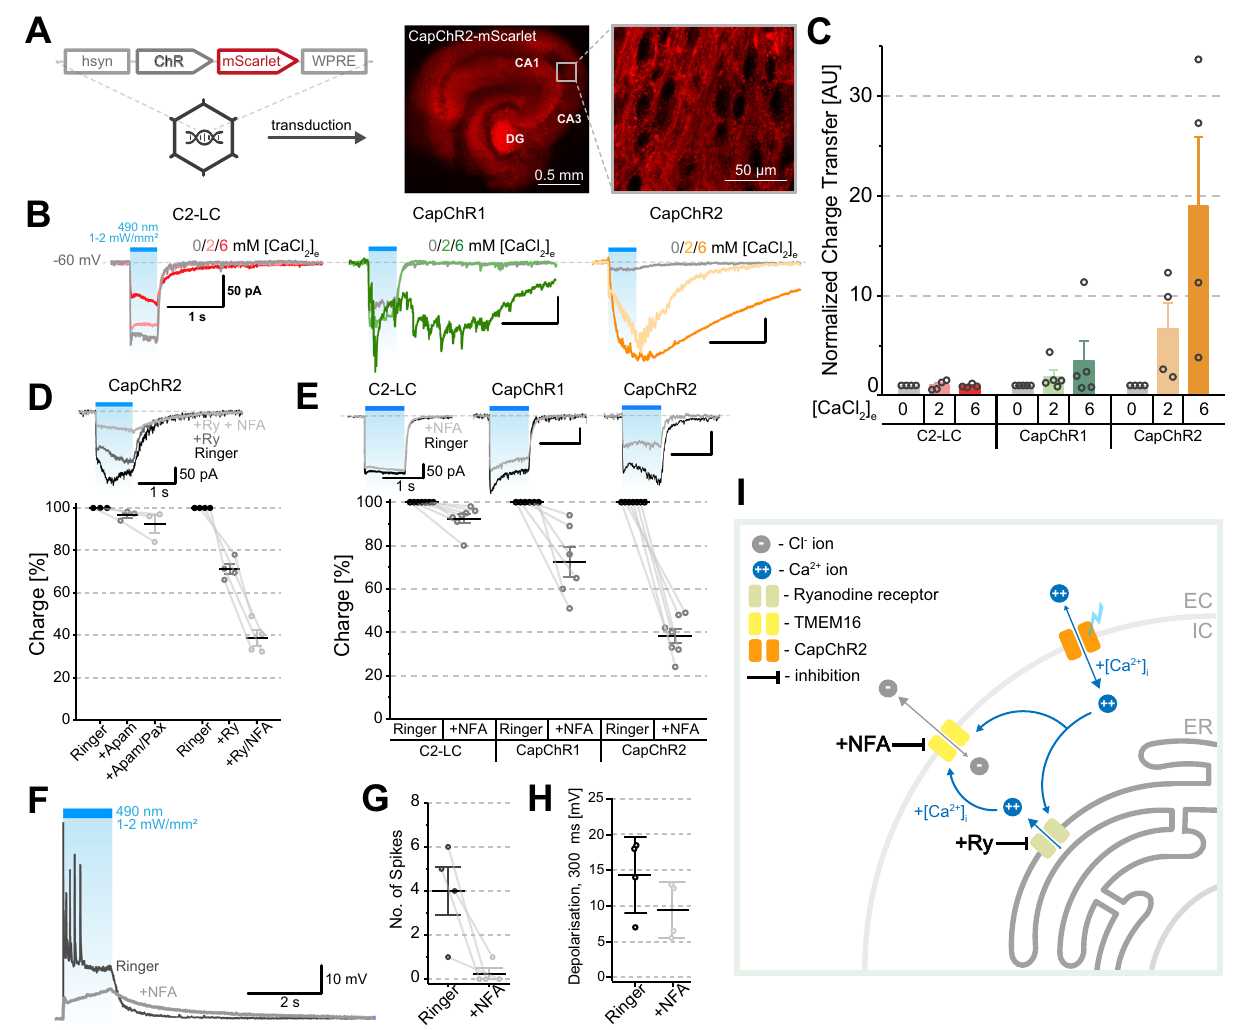
Fig. 6 | Electrophysiological characterization of CapChRs in organotypic hip- pocampalsliceculture.A Constructdesignand fl uorescentconfocalmicrographs showing organotypic hippocampal cultures (DIV 20) transduced with AAVs- expressing mScarlet-tagged ChRs. All three constructs C2-LC, CapChR1 and CapChR2werehomogeneouslyexpressedthroughoutthehippocampaltissueafter 3 – 4dayspost-transduction(exampleshownforCapChR2). B Representativewhole cell current traces depicting the effects of 500ms of 490nm (1 – 2mW/mm 2 , saturating) light exposure at different calcium concentrations. C Charge transfer (normalized to valuesat0mM [CaCl 2 ] e )between1 and 2sofillumination ( n =4for C2-LC; n =5 for CapChR1; n =4 for CapChR2). D Photocurrents from CapChR2 in presence of blockers and the total charge transfer in % of the control. Apamin (Apam; 10 µ M) Paxilline (PAX; 10 µ M) ( n =3), Ryanodine (Ry, 50 µ M) ( n =4) and